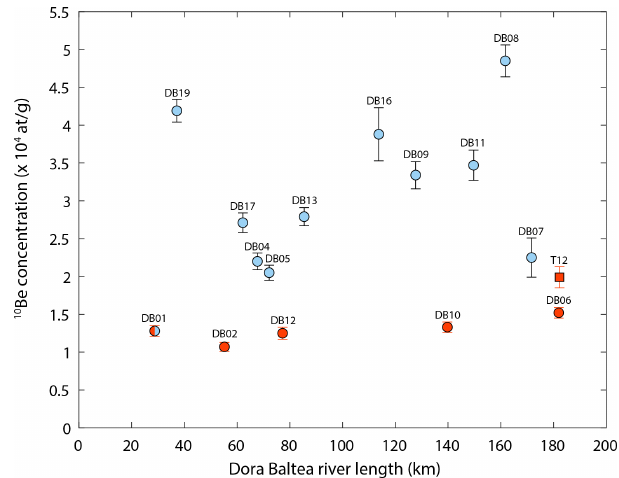
Figure 3. Downstream evolution of river-sand 10 Be concentrations in the Dora Baltea (DB) catchment. Data are plotted versus dis- tance from the main DB source (upper Val Veny, right tributary upstream DB01). In red are samples collected along the main DB river; in light blue are samples at the outlet of tributaries (Fig. 1 for locations). 10 Be concentration of sample T12 (red square) from Wittmann et al. (2016) is also shown for discussion. Samples DB03, 14 and 18 are omitted since they do not directly connect to the main DR river, but note that their 10 Be concentrations are similar to those of the tributaries into which they drain (DB04 and DB13, respec- tively; Fig. 2 and Table